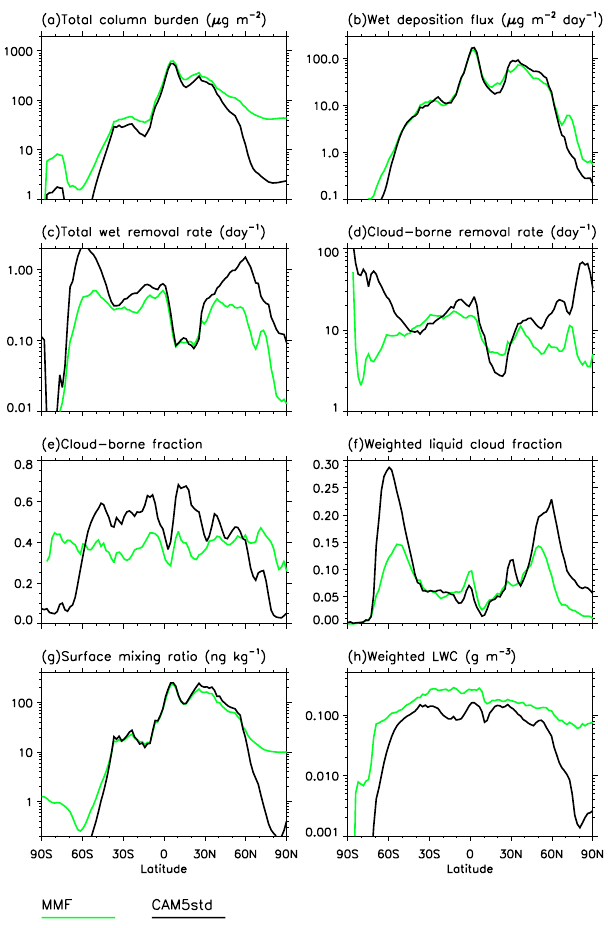
Fig. 1. DJF zonal-mean values of the quantities related to BC burden and removal, as described in Eqs. (1)–(3), derived from the MMF and the standard CAM5 simulations. The column burden is the ver- tical integral from the surface to